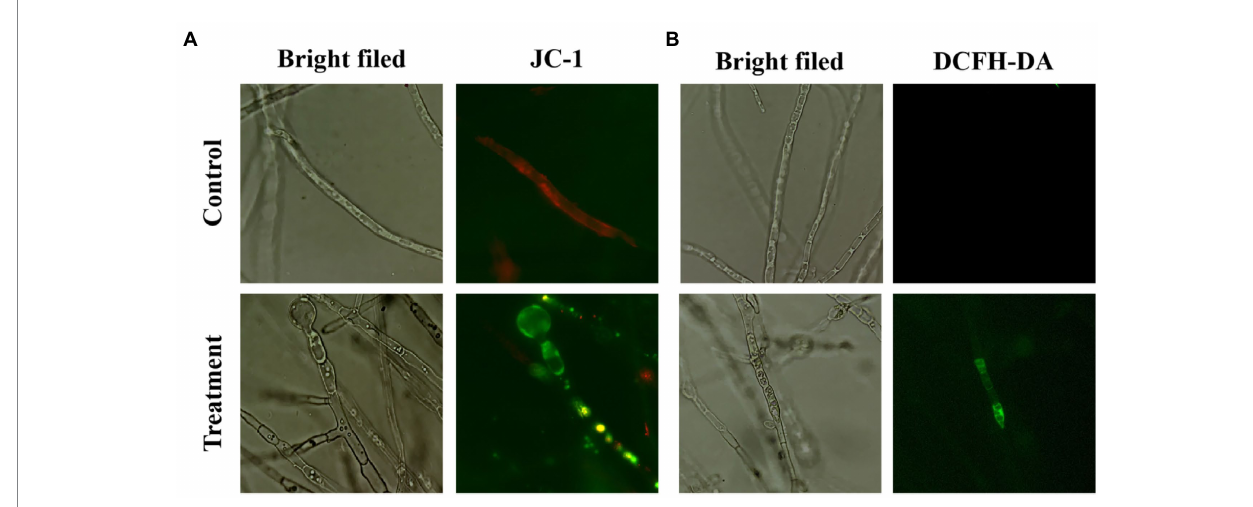
FIGURE 6 Effect of cell-free culture filtrate induced alteration of mitochondrial membrane potential (MMP) and reactive oxygen species (ROS) generation in Bacillus amyloliquefaciens cells. (A) Effect of cell-free culture filtrate on mitochondrial membrane potential of hyphal cells (×40). (B) Accumulation of